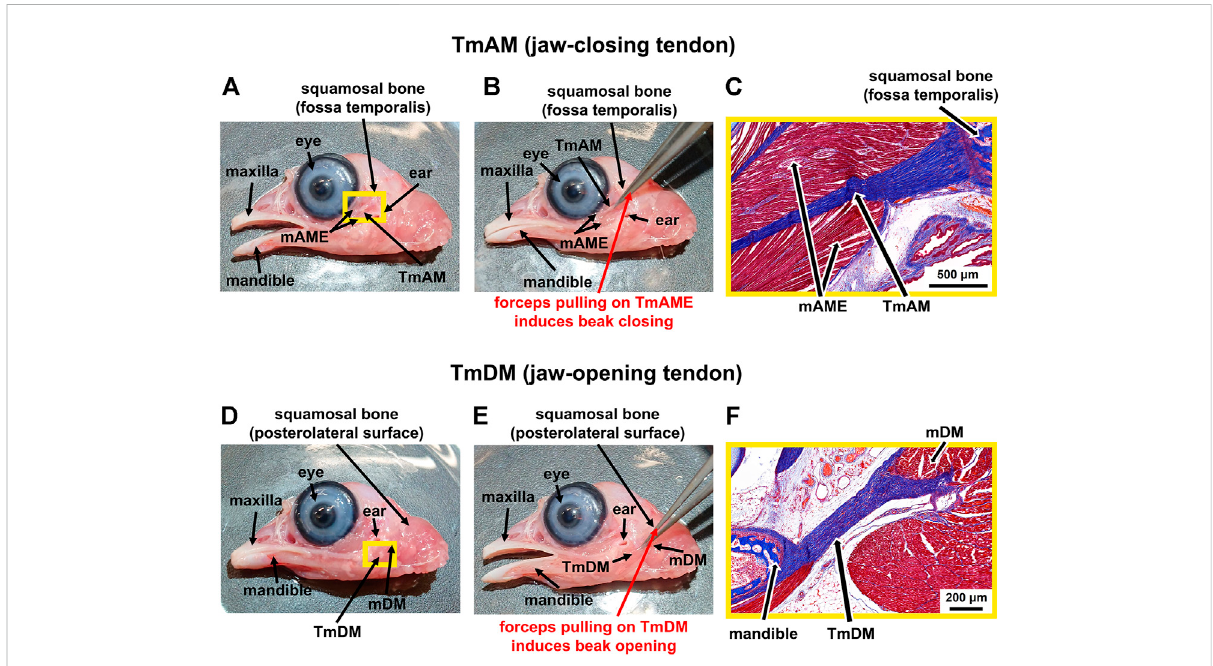
FIGURE 1 Identi fi cation of jaw-closing TmAM and jaw-opening TmDM in a d19 chick embryo. (A) Macroscopic view showing location of the jaw-closing TmAM with beak open. (B) Pulling the TmAM with a forceps induced closing of the jaw. (C) Mallory ’ s trichrome staining of tissue regions highlighted byyellowrectangle inFigure 1Ashows origin ofTmAM (blue)atfossa temporalis ofsquamosalbone (darkblue) andattachmentof mAME(red) along both sides of the TmAM. (D) Macroscopic view showing location of the jaw-opening TmDM with beak open. (E) Pulling the TmDM with a forcepsinducedopeningofthejaw. (F) Mallory ’ strichromestainingoftissueregionshighlightedbyyellowrectangleinFigure1Dshowsattachments at each end of the TmDM (blue) to mDM (red) and mandible (dark